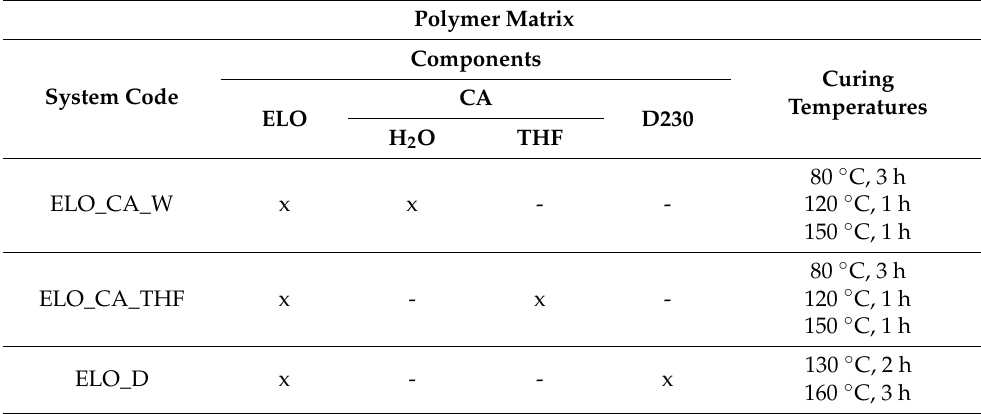
Table 1. ELO-based formulations and the used curing parameters.